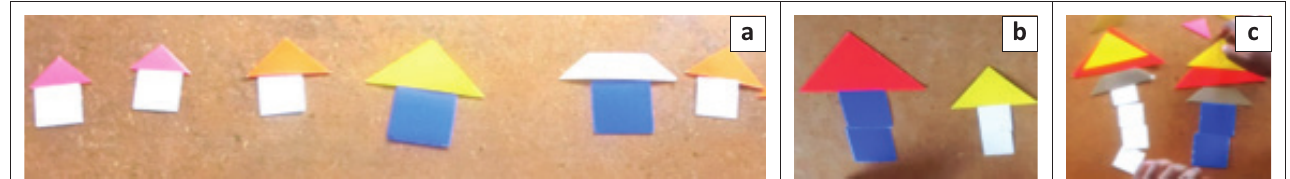
FIGURE 4: Houses that children produced in the second lesson.